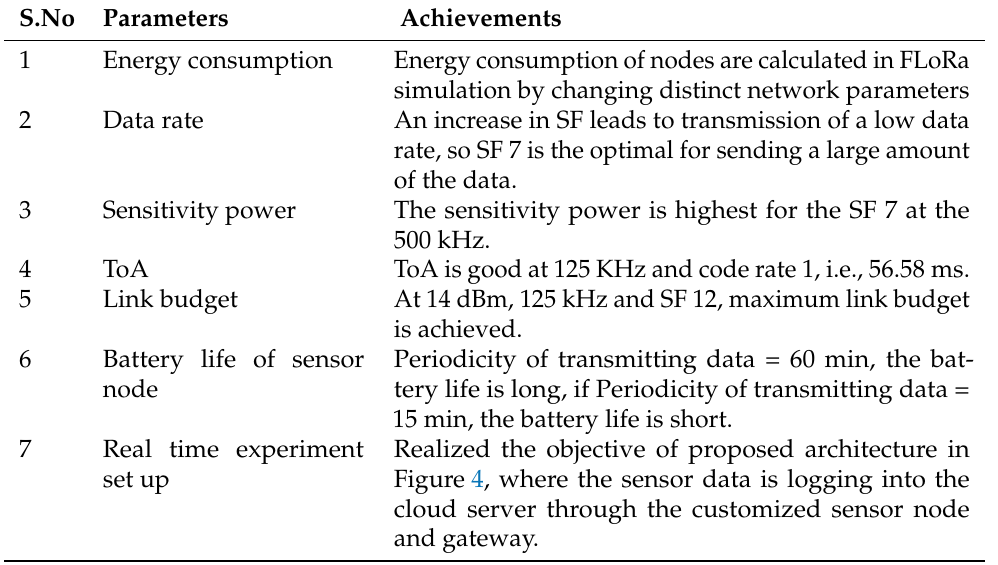
Table 13. Achievements from the result